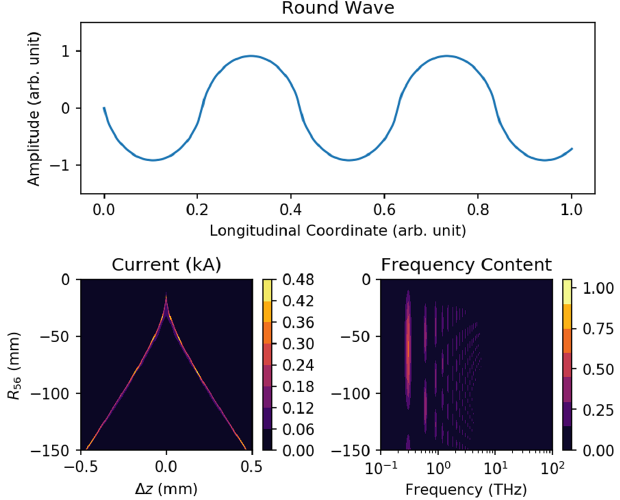
FIG. 5. Top: plot of an N ¼ 11 round wave modulation according to Eq. (10). Bottom: contour plots of both the beam current within a single fundamental modulation wavelength λ ¼ 1 mm, as well as the frequency content of the bunch vs 0 the longitudinal dispersion R 56 . Here, Δ z ¼ z − λ 0 = 2 . The scan was performed for N ¼ 11 . The idealized input current and modulation depth is assumed to be the same as described in Fig.